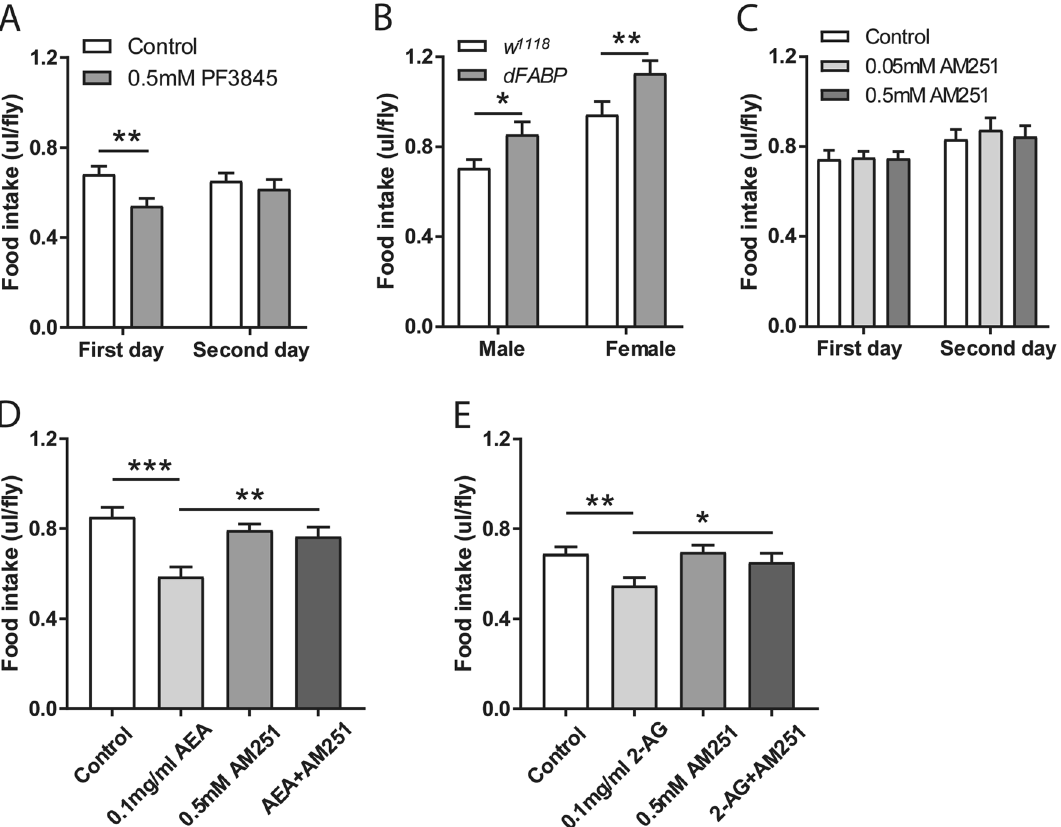
Figure 6. AM251 attenuated the inhibitory effects of AEA on food intake. ( A ) While inhibition of FAAH with 0.5 mM PF3845 led to a significant decrease in the consumption of normal food on day 1 (n = 18). ( B ) Overexpression of dFABP in flies significantly increased food intake (n = 16–19). ( C ) Food intake was not altered following AM251 pre-treatment (n = 18). Administration of 0.5 mM AM251 significantly mitigated the decreases in food intake induced by 0.1 mg/ml AEA ( D ) and 0.1 mg/ml 2-AG ( F ) on day 1 (n = 16–24 vials/ group). All data are represented as mean ± S.E.M. One-sample t test and one-way ANOVA followed by Dunnett’s post-hoc test were used to analyze the difference. * p < 0.05, ** p < 0.01, and *** p <